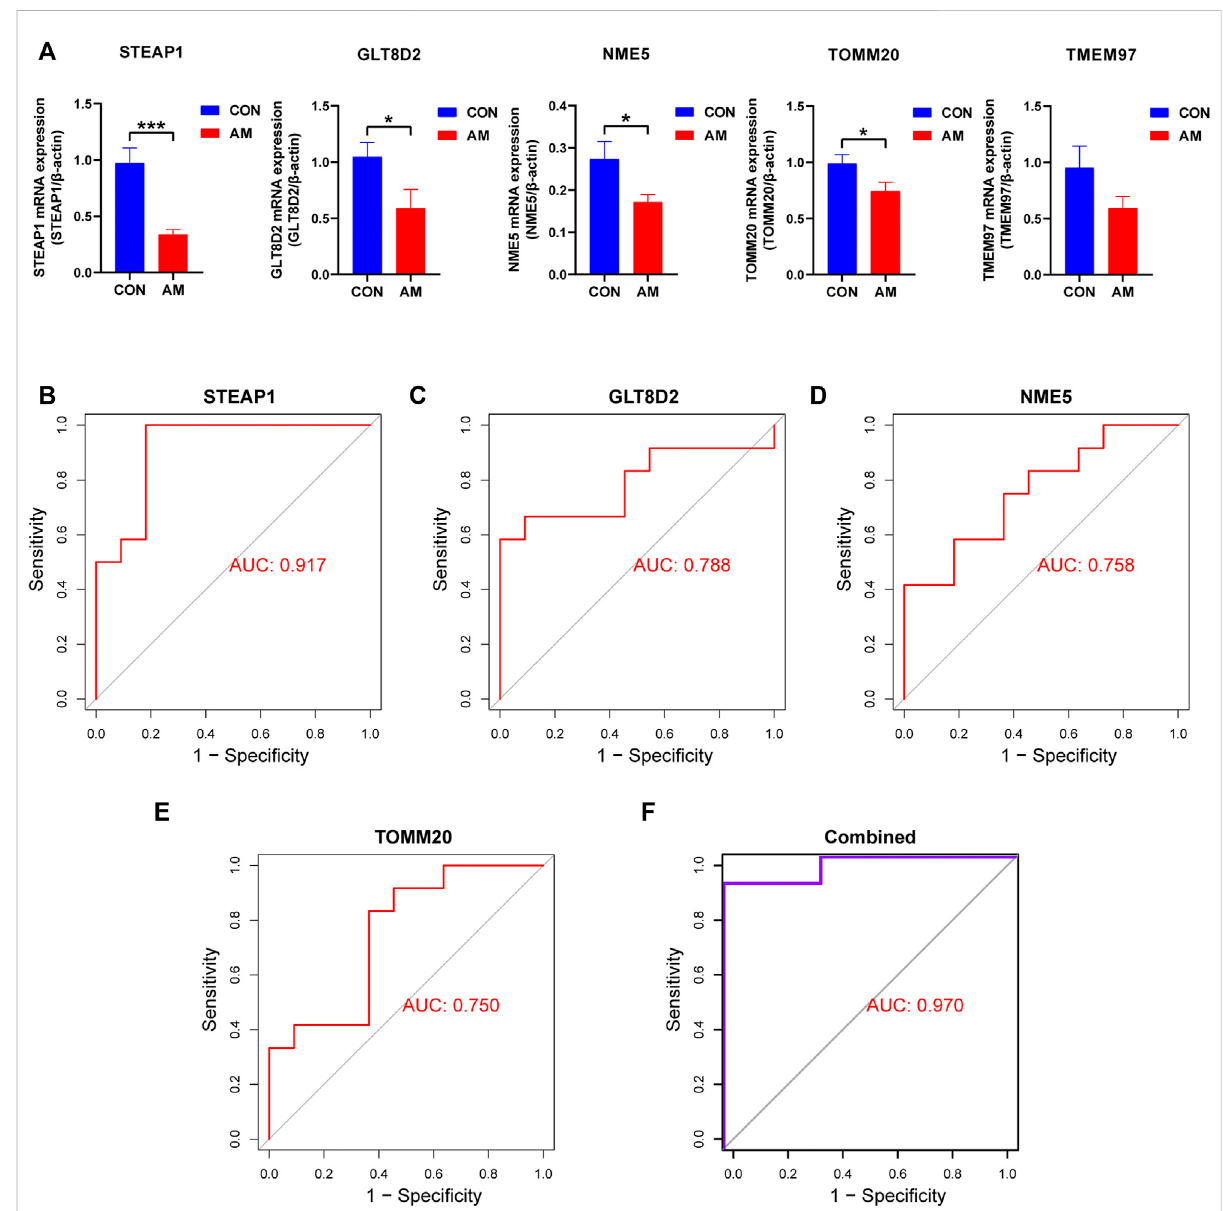
FIGURE 5 Validation of hub genes using qRT-PCR. (A) Validation of the expression of candidate diagnostic biomarkers using qRT-PCR. Four diagnostic biomarkers, namely, STEAP1, GLT8D2, NME5, and TOMM20, were downregulated signi fi cantly in the endometrium of women with adenomyosis compared with the control group. The downregulation of TMEM97 did not show statistical signi fi cance. (B – E) The ROC curve analysis and calculation of the AUC of STEAP1, GLT8D2, NME5, and TOMM20 in the clinical samples. (F) The ROC curve to verify the diagnostic ef fi cacy of the combined four diagnostic markers using logistic regression analysis (* p < 0.05, ** p < 0.01, *** p < 0.001, **** p < 0.0001). AUC: area under the curve; GLT8D2: glycosyltransferase eight domain-containing two; NDPK: nucleoside-diphosphate kinase; NME5: NME/NM23 family member fi ve expressed in nucleoside-diphosphate kinase; STEAP1: six-transmembrane epithelial antigen of the prostate-1; SVM-RFE: support vector machine- recursive feature elimination; TOMM20: translocase of outer mitochondrial membrane 20; TMEM97: transmembrane protein 97; qRT-PCR: quantitative reverse transcriptase PCR; ROC: receiver operating